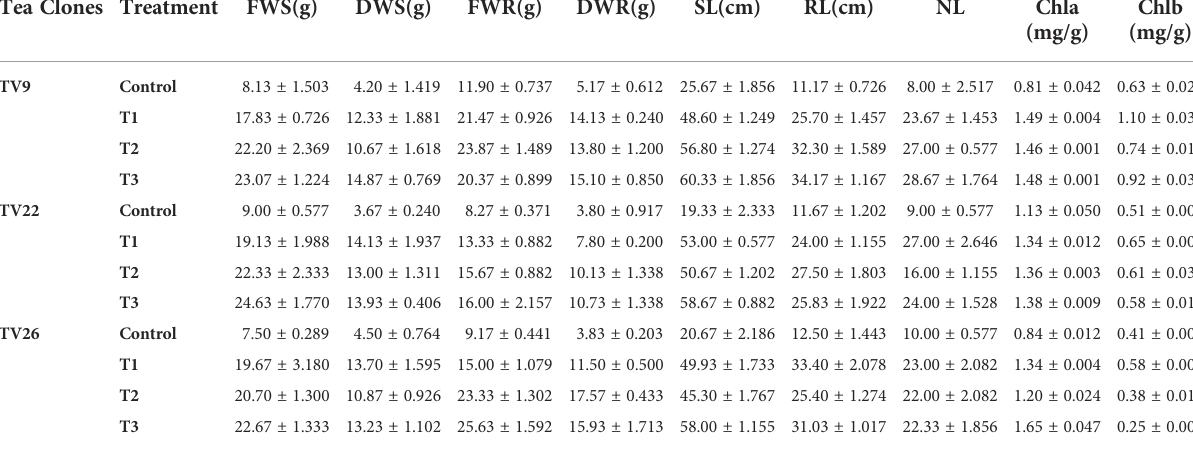
TABLE 6 Growth parameters of tea clones inoculated with two potent actinobacterial strains in nursery conditions. Tea Clones Treatment